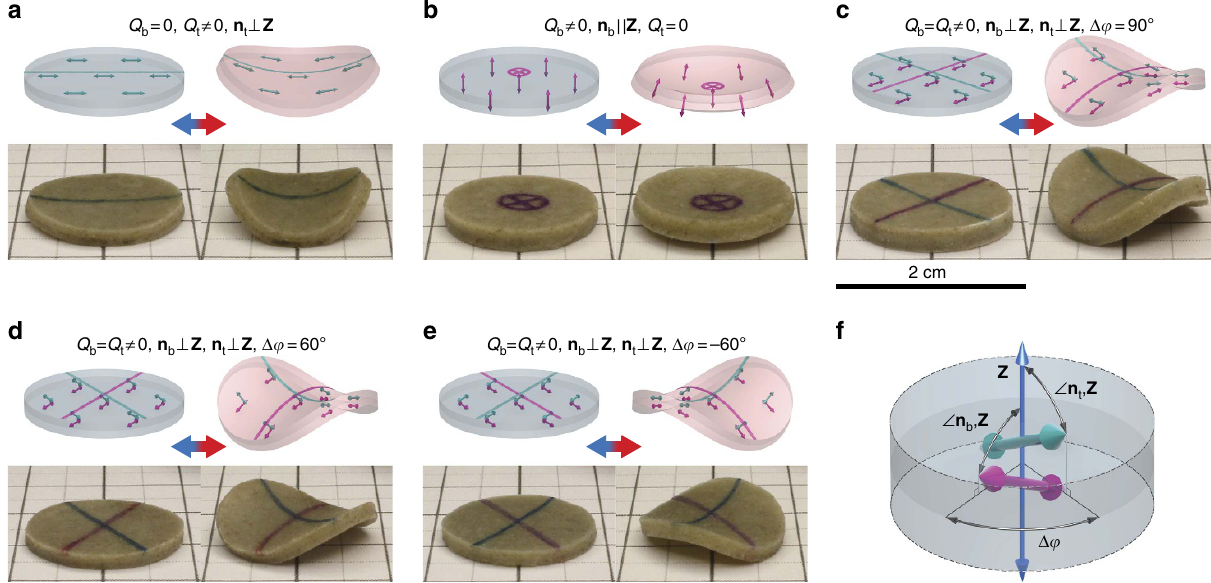
Figure 5 | Programmable shape memory of PDLCEs with bilayer director field. Desirable thermomechanical response is instilled by configuring m LCE orientational order Q and orientation of nematic director n in the top and bottom PDLCE layers (indices t and b), respectively. All basic thermomechanical actuation modes, specifically bend deformation ( a ), cup deformation ( b ), saddle deformation ( c ), as well as left twist ( d ) and right twist ( e ) deformation can be realized by a suitable choice of Q t and Q b , of the orientation of n t (cyan double arrows) and n b (magenta double arrows) with respect to the surface normal Z of the sample, as well as of the relative azimuth D j between n t and n b ( f ). In each of panels a – e , the particular m LCE configuration and anticipated sample shape is depicted schematically in the two icons at the top, with the left one representing low-temperature state ( T o T l , blue-tinted PDMS matrix) and the right one representing high-temperature state ( T 4 T l , red-tinted PDMS matrix). Temperature-controlled shape morphing of real PDLCE-A bilayer samples is demonstrated with respective photographs at the bottom of panels a – e , the left one showing the specimen at T ¼ 300K and the right one showing the specimen at T ¼ 400K. Cyan (top layer) and magenta (bottom layer) solid lines and cross-hairs mark the respective directions of macroscopic thermomechanical anisotropy